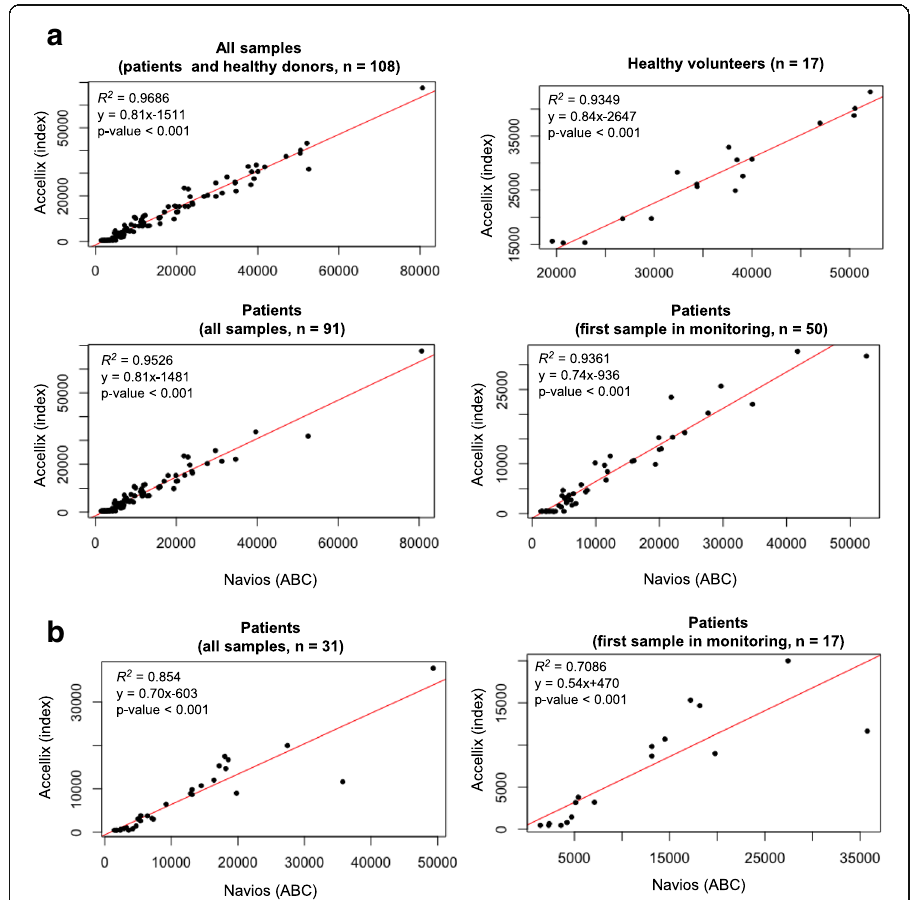
Fig. 2 Comparison of mHLA-DR expression measurement between Accellix (mHLA-DR index) and Navios (ABC). a 108 blood samples (retrospectively analyzed with modified algorithm) as: upper left (all samples), upper right (only healthy volunteers), lower left (septic patients: all samples), lower right (septic patients: only first sample in the monitoring course). b 31 blood samples from 17 septic patients (prospectively analyzed) as: left (all samples), right (only first sample in the monitoring